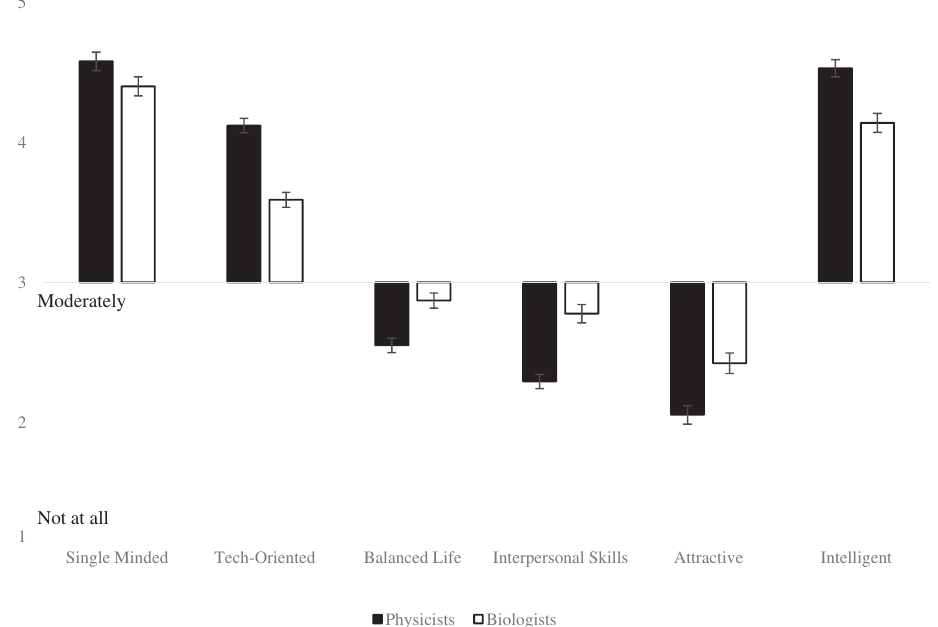
FIG. 1. Bar graph of person characteristic stereotypes. The error bars represent standard error. See Table II for sample